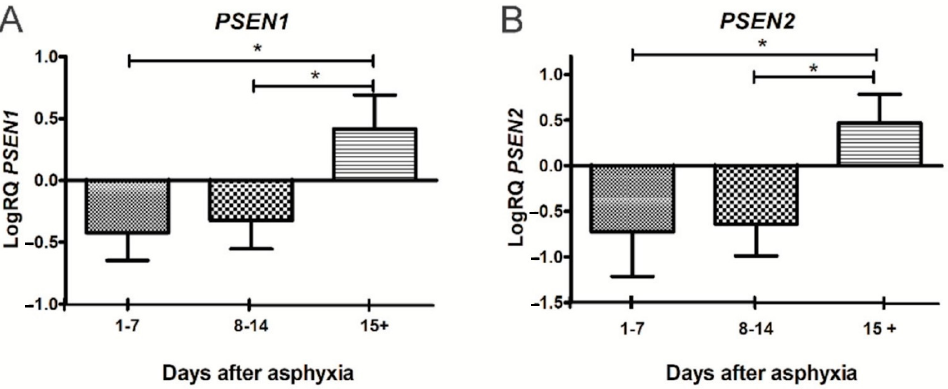
Figure 2. Changes of presenilin 1 (PSEN1) and presenilin 2 (PSEN2) genes after perinatal asphyxia. ( A ). Mean levels of PSEN1 gene expression in lymphocytes after perinatal asphyxia in age groups 1–7 (n = 8), 8–14 (n = 7), and 15+ (n = 10) days. Marked SD, standard deviation. N, number of children in the group. The changes between the 1–7 and 8–14 day groups were not statistically significant. The indicated statistically significant differences in the level of gene expression between groups 1– 7 and 15+ days (z = 3.903, p = 0.0002) and between 8–14 and 15+ days (z = 3.092, p = 0.0059) after perinatal asphyxia (Kruskal-Wallis test). * p ≤ 0.01. ( B ). Mean levels of PSEN2 gene expression in lymphocytes after perinatal asphyxia in age groups 1–7 (n = 8), 8–14 (n = 7), and 15+ (n = 10) days. Marked SD, standard deviation. N, number of children in the group. The changes between the 1–7 and 8–14 day groups were not statistically significant. The indicated statistically significant differ- ences in the level of gene expression between groups 1–7 and 15+ days (z = 3.634, p = 0.0008) and between 8–14 and 15+ days (z = 3.387, p = 0.002) after perinatal asphyxia (Kruskal-Wallis Test). * p ≤ 0.01. [3]. 2. Materials and Methods 2.1. Study Setting and Design In this study, we compare children with perinatal asphyxia with a group of children with perinatal asphyxia treated with hypothermia with survival exceeding 15 days, born in the Lublin region, Poland. During the study, all newborns were hospitalized at the De- partment of Neonate and Infant Pathology at the Medical University of Lublin. The inclu- sion criteria for asphyxia were defined as follows: •